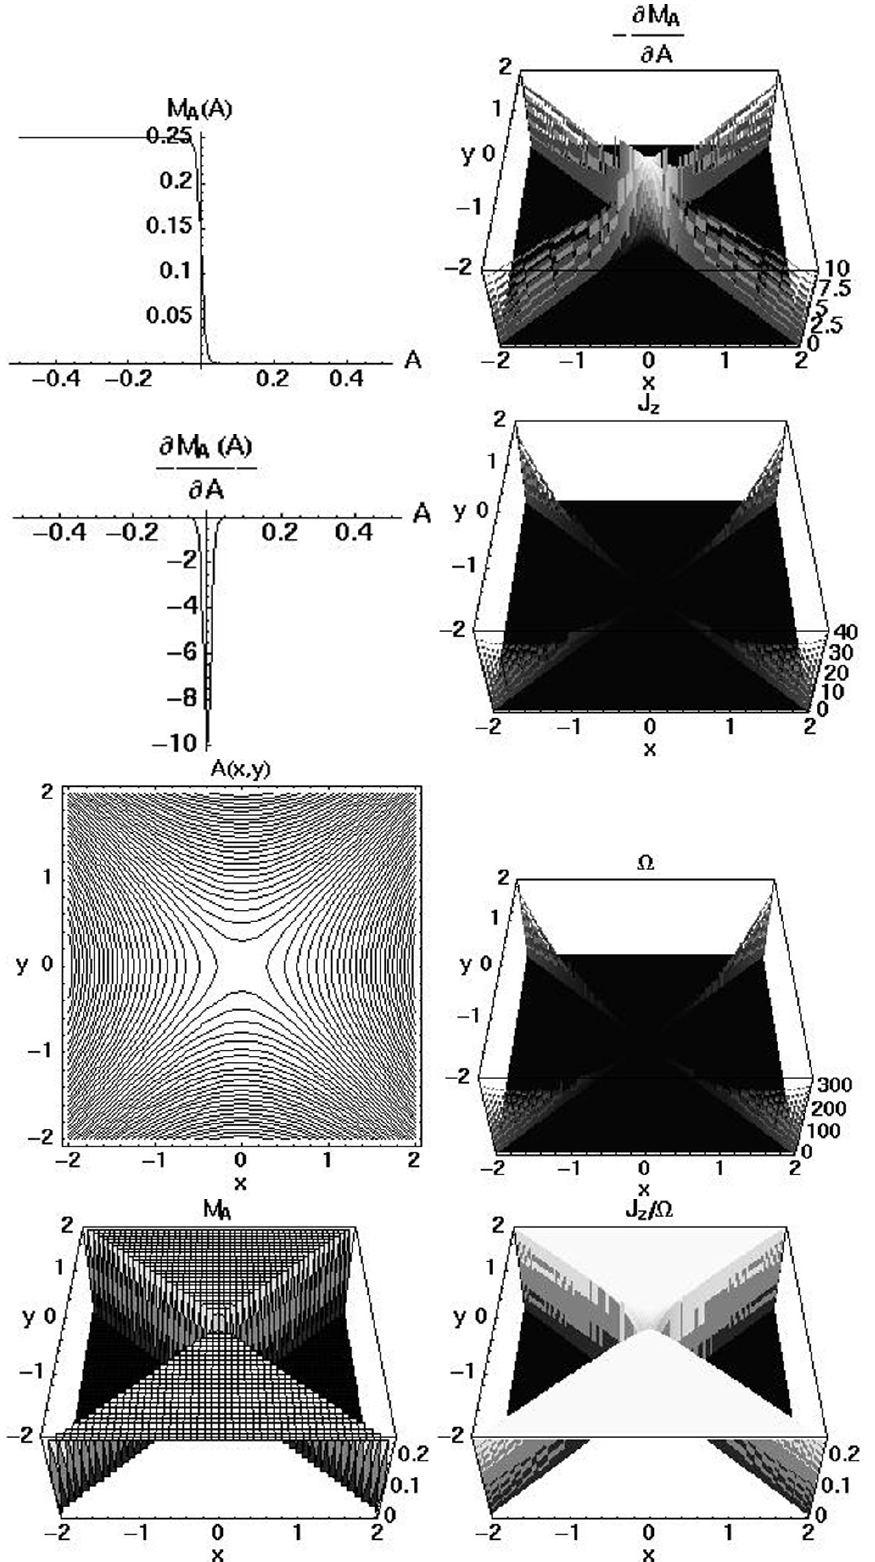
Fig. 2. Transformation from an initial potential field, similar as in Fig. 1, but with a much steeper Mach-number profile (see Eq. 37 with M Amax = 0 . 25 and d = 0 . 2 /